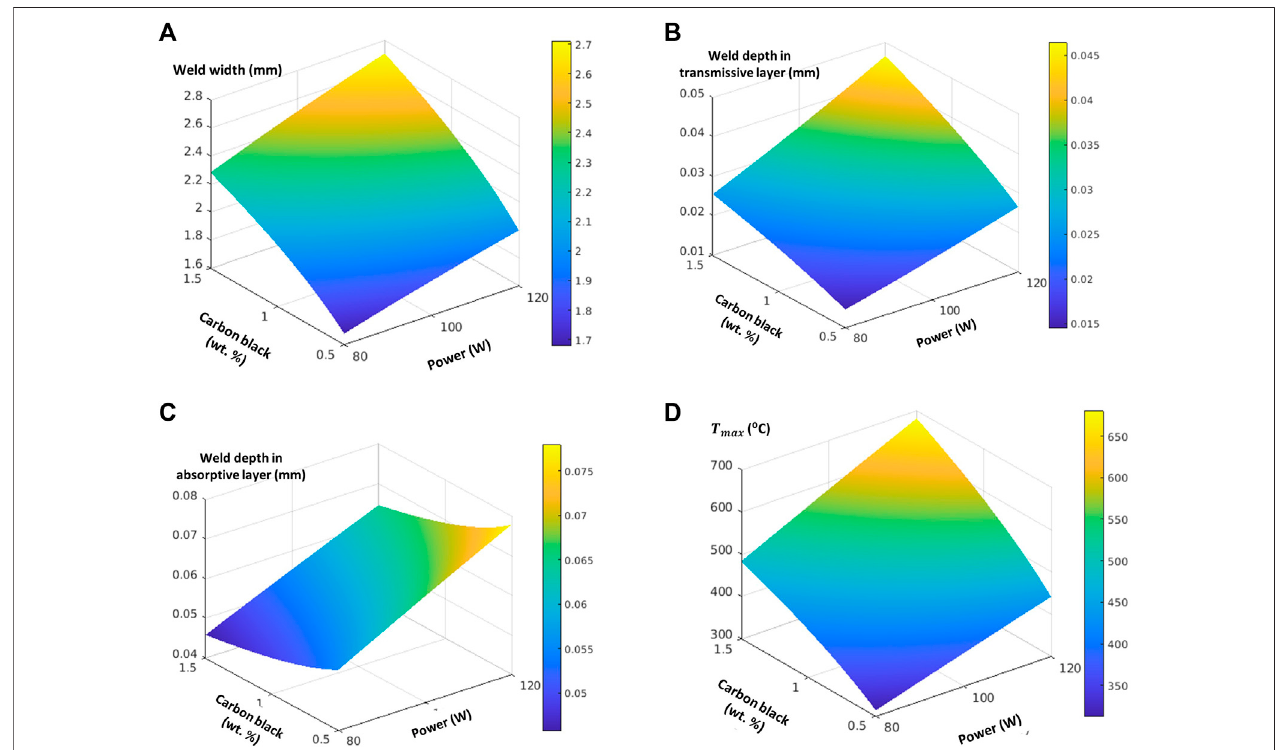
FIGURE 9 | (A) Simultaneous effect oflaser power and carbon black content onthe weld width (constant parameters: welding speed (cid:1) 1,200 mm/s, and diameter (cid:1) 2 mm), (B) Simultaneous effect of laser power and carbon black content on the weld depth of transmissive layer (constant parameters: welding speed (cid:1) 1,200 mm/s, and diameter (cid:1) 2 mm), (C) Simultaneouseffectoflaserpowerandcarbonblackcontentonthewelddepthofabsorptivelayer(constantparameters:weldingspeed (cid:1) 1,200 mm/ s, and diameter (cid:1) 2 mm) and (D) Simultaneous effect of laser power and carbon black content on maximum weld temperature of transmissive layer (constant parameters: welding speed (cid:1) 1,200 mm/s, and diameter (cid:1) 2